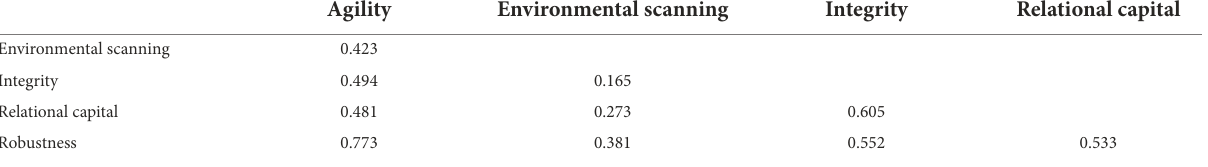
TABLE 5 Heterotrait-Monotrait Ratio (HTMT).